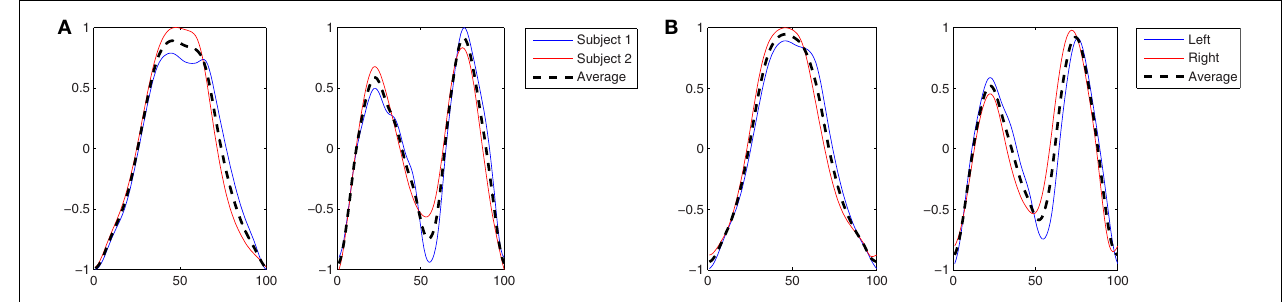
FIGURE 4 | (A) The two kMPs extracted from the two subjects reaching a target with the left hand. (B) Comparison between the average kMPs of reaching a target with the left and the right hand.